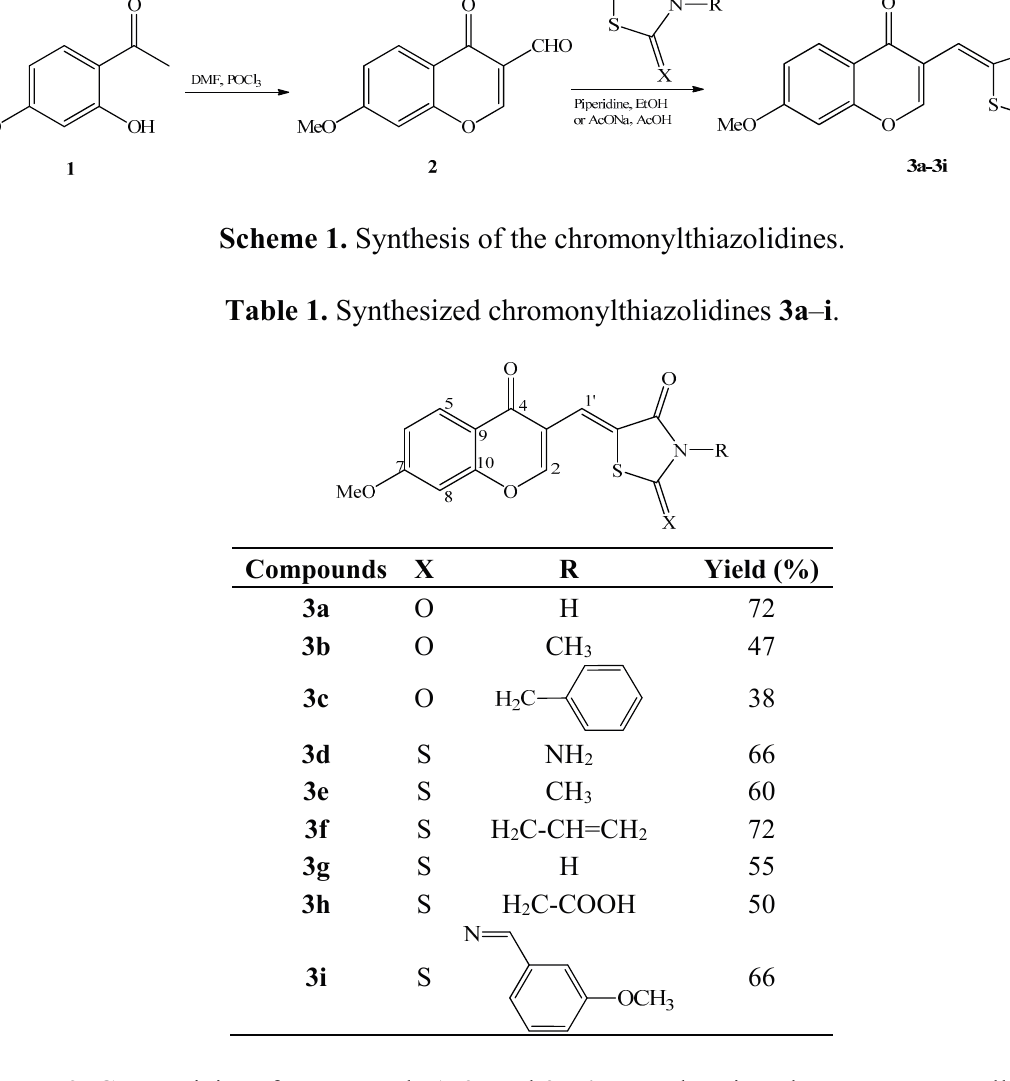
Table 2. Cytotoxicity of compounds 1 , 2 , and 3a – i toward various human cancer cell lines.